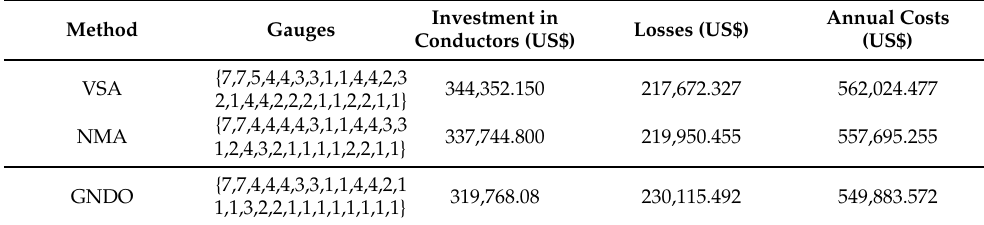
Table 10. Solutions obtained by different optimization